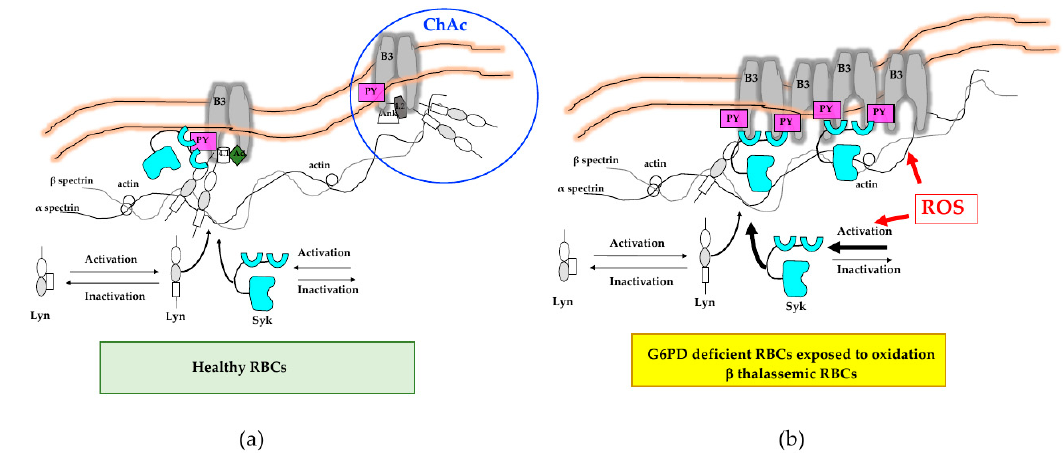
Figure 3. Schematic diagram of the main cell signaling pathway involved in red cell homeostasis. ( a ) Under steady state conditions, Lyn and Syk are inactive. Cellular stress such as physiologic oxidation related to aging or osmotic stress triggers Lyn–Syk sequential activation, resulting in increased tyrosine (Tyr) band 3 (B3) phosphorylation (PY). This modulates B3 interaction with neighboring proteins such as band 4.1, band 4.2, or adducin or ankyrin. These multiprotein complexes bridging the membrane to the cytoskeleton contribute to membrane mechanical instability. Red cells from patients with chorea-acanthocytosis (ChAc) loose the canonical Lyn–Syk signaling pathway targeting B3, resulting in membrane–cytoskeleton network instability. ( b ) Red cells from patients with either G6PD deficiency exposed to oxidation or β -thalassemia are characterized by severe oxidation. This results in membrane damage and abnormal activation of Syk independently from the canonical Syk–Lyn pathway. The damaged, over-Tyr phosphorylated B3 forms clusters, which favor erythroid vesicle release and the fast removal of the damaged red cells by splenic macrophages.